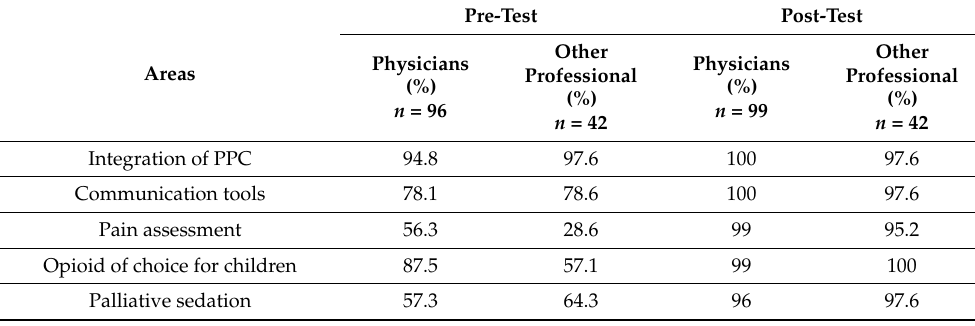
Table 2. Description of answers assessed between physicians and non-physicians in pre-test and